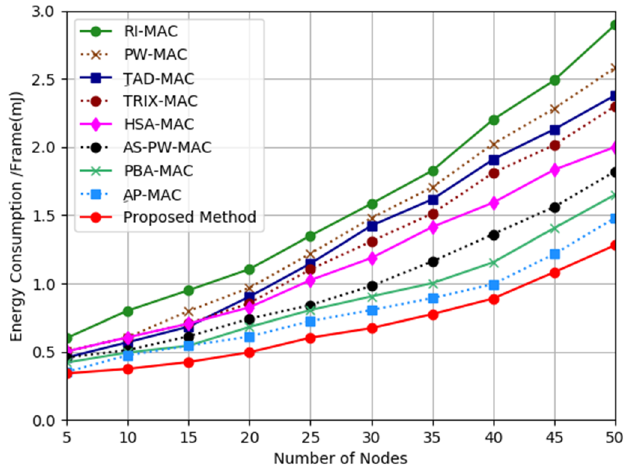
Figure 3. Energy consumption Figure 4. Energy consumption analysis.